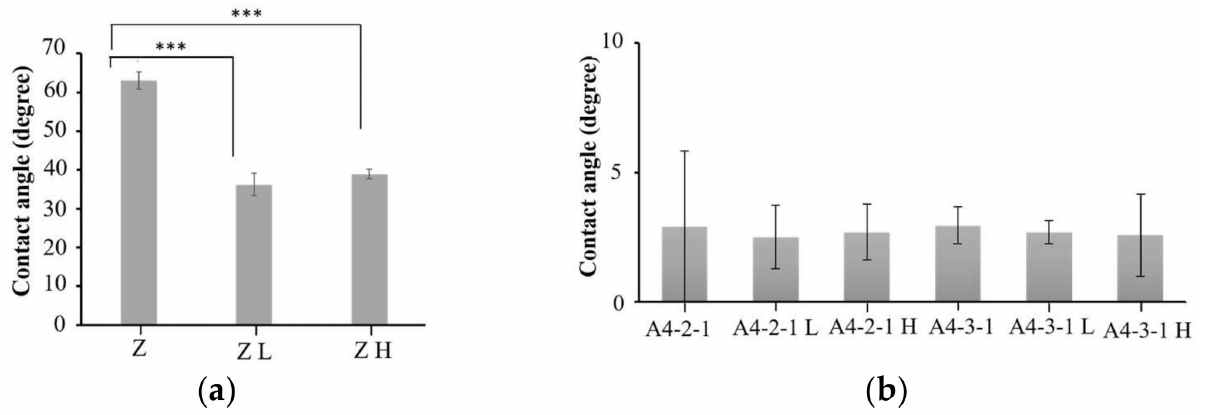
Figure 14. No significant difference. ( a ) Comparison of the surface hydrophilicity of untreated zirconia materials (*** p < 0.001). ( b ) Comparison of the hydrophilicity before and after A4-2-1 and A4-3-1